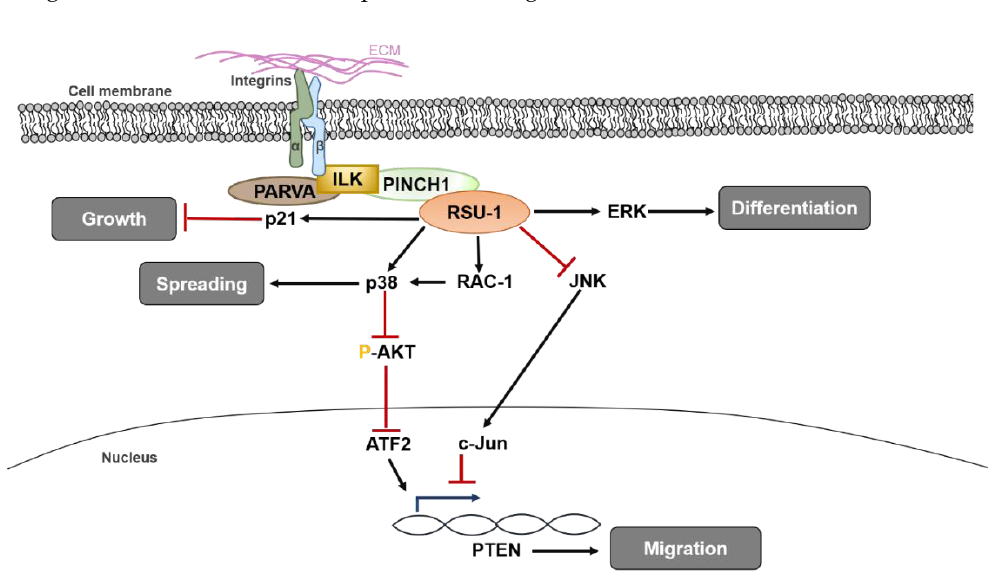
Figure 1. Diagrammatic representation of the role of RSU1 in normal tissues, where it regulates fundamental cellular processes such as spreading, migration, differentiation and proliferation of normal cells. ATF2: Activating Transcription Factor-2, ERK: Extracellular Regulated Kinase, ILK: integrin Linked Kinase, JNK: c-Jun N terminal kinase, PARVA: alpha parvin, PINCH-1: Particularly Interesting New Cysteine-Histidine rich protein, PTEN: Phosphatase and Tensin homologue, RAC-1: Ras-related C3 botulinum toxin substrate 1.